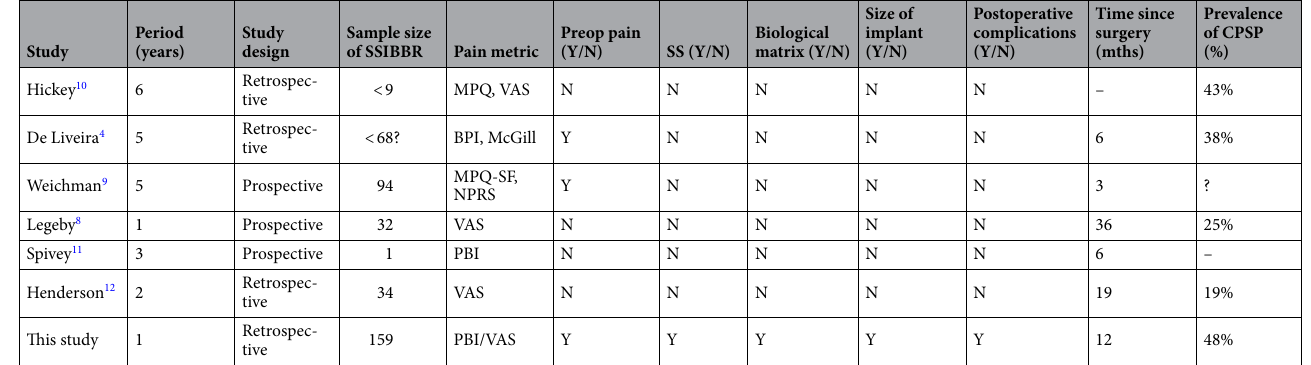
Table 5. Summary of methodological parameters for studies investigating CPSP following single-stage IBBR. MPQ-SF McGill pain questionnaire-short form, VAS visual analog scale, NPRS numerical pain